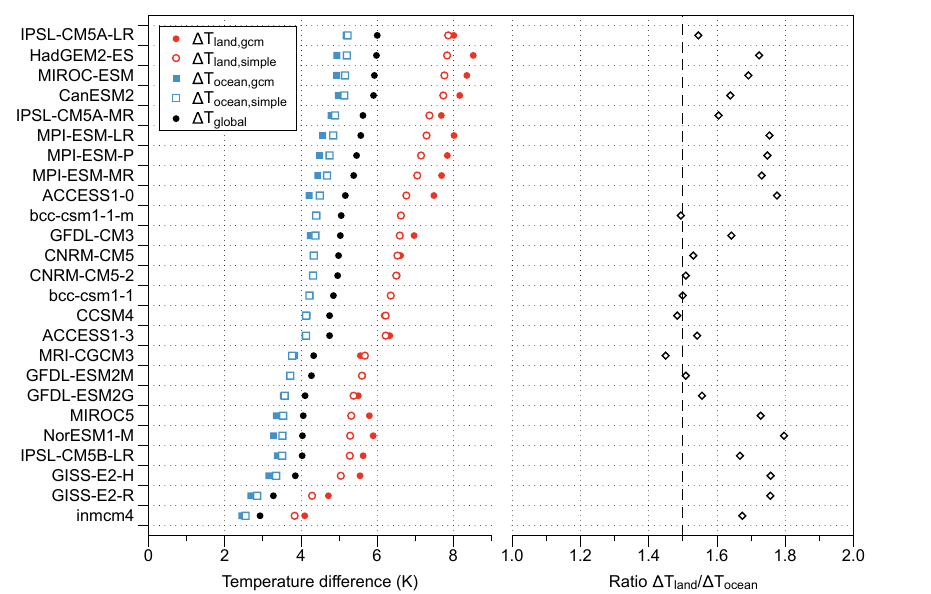
Figure 6. Global mean response of 25 CMIP5 climate model simulations. Shown is the mean warming of the ocean surface ( (cid:49)T ocean , gcm , blue solid squares), the land surface ( (cid:49)T land , gcm , red solid circles), and the global mean ( (cid:49)T global , black dots) between the 4 × CO 2 and preindustrial control simulations. Also shown are the equivalent changes ( (cid:49)T ocean , simple , blue open squares, and (cid:49)T land , simple , red open circles) predicted from the energy balance considerations made here. The right diagram directly compares the ratio φ = (cid:49)T land /(cid:49)T ocean from the GCM simulations (diamonds) to the prediction made here (dashed